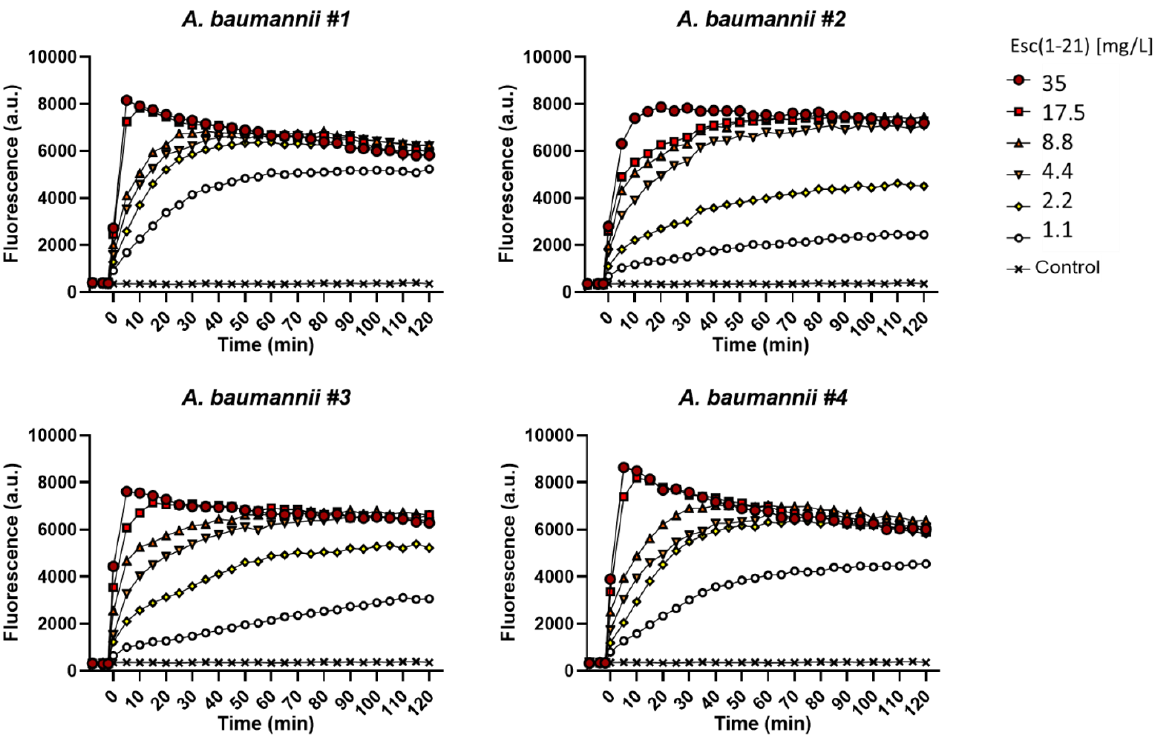
Figure 2. Growth kinetics for the different A. baumannii strains in the presence of colistin (Col, at its 1/2, 1/4 and 1/8 MIC FIC ), Esc(1-21) (at its MIC FIC ) and their combinations. Results are of the mean ± SD of three independent experiments.